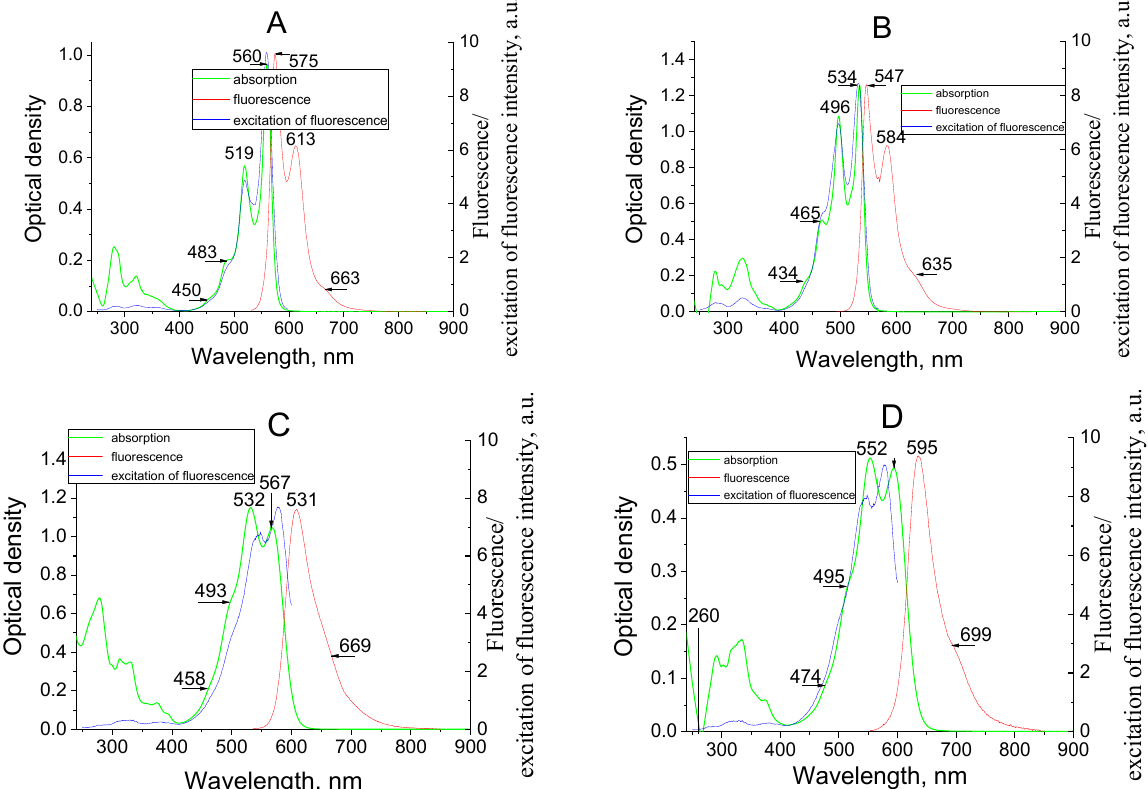
Figure 3. Absorption, fluorescence, and excitation of fluorescence spectra of dyes I ( A ), II ( B ), III ( C ), IV( D ) in tetrahydrofuran (concentration 1 × 10 − 6 g/ с m 3 , T = 293 K).